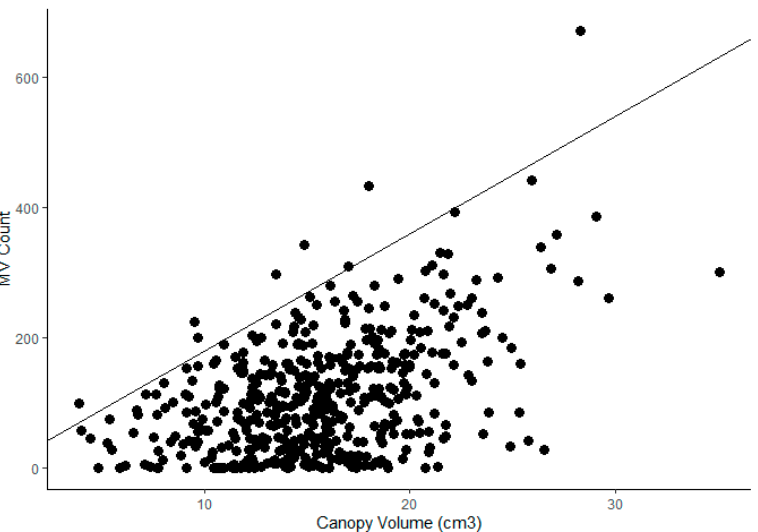
Figure 7. Relationship between tree fruit load and tree canopy volume as assessed using LiDAR for 494 trees of a single mango orchard. Line with slope of 18 fruit/m 3 bounds 99% of observations.